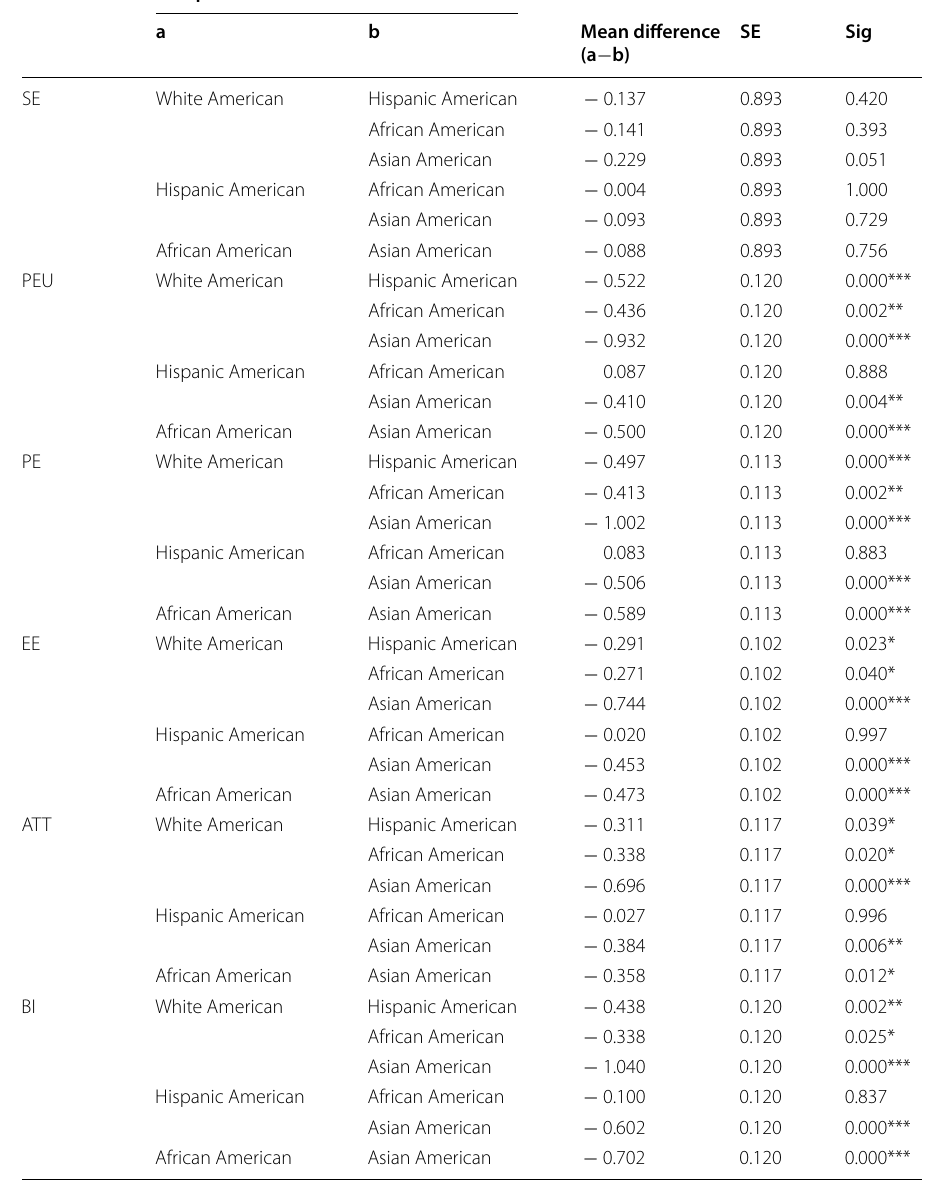
Table 6 The results of construct mean comparison among ethnic